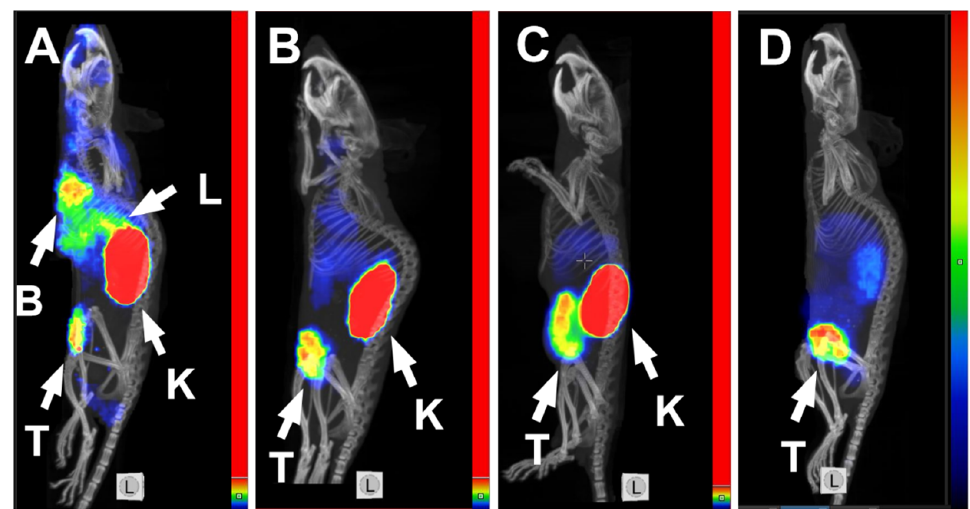
Figure 5. MicroSPECT/CT imaging of HER2-expression in mice from the PBS group using 99m Tc(CO) 3 -ADAPT6-ABD-mcDM1 at ( A ) 4 h and ( B ) 24 h p.i., ( C ) using at 4 h p.i. and ( D ) using 99m Tc-Z HER2:41071 at 4 h p.i. The arrows with the letters “T”, “K”, “L” and “B” point to the tumors, kidneys, liver and blood pool in the heart, respectively. The color scale sidebars show the relative activity and are adjusted to the first red pixel in tumors.